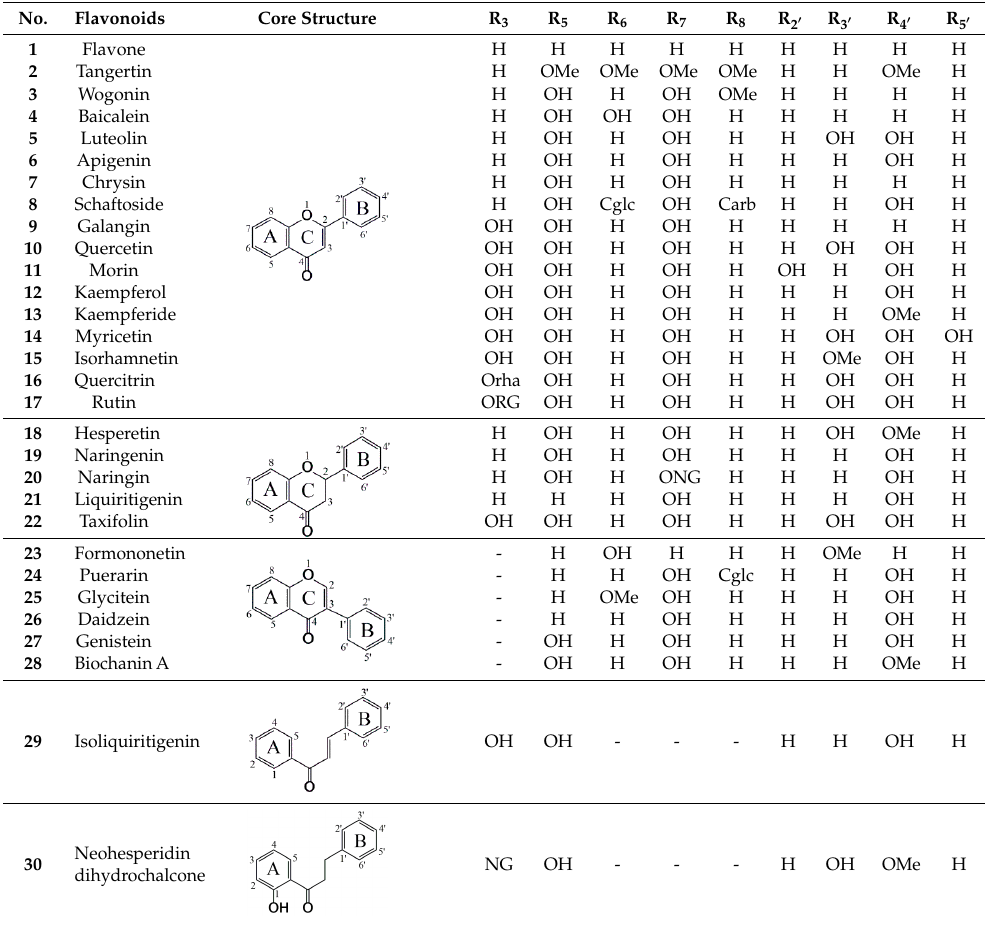
Table 1. The chemical structures of 30 flavonoids.